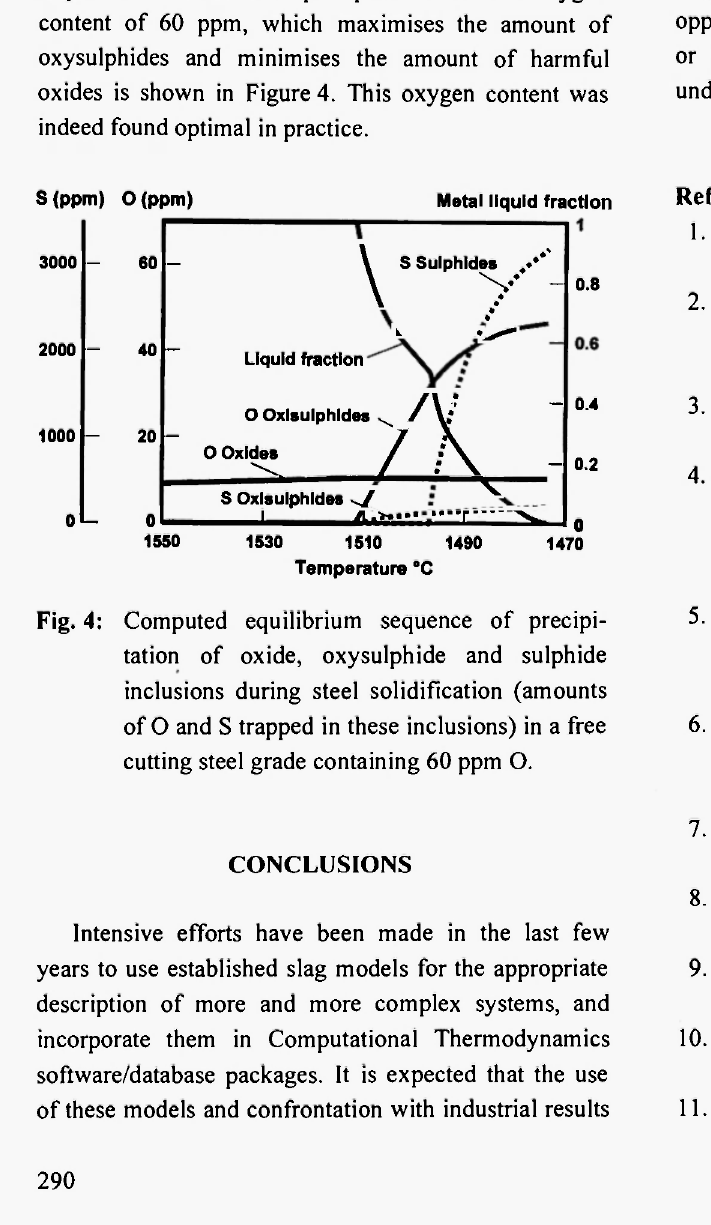
Fig. 4: Computed equilibrium sequence of precipi- tation of oxide, oxysulphide and sulphide inclusions during steel solidification (amounts of Ο and S trapped in these inclusions) in a free cutting steel grade containing 60 ppm